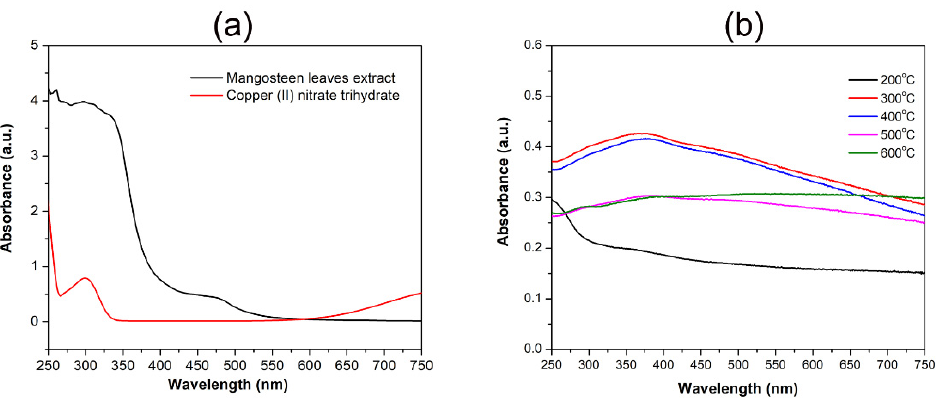
Figure 1. UV-Vis spectrum of the ( a ) mangosteen leaf extract and copper salt and ( b ) G. mangostana L. leaf extract-mediated synthesized CuO NPs at different calcination temperatures.